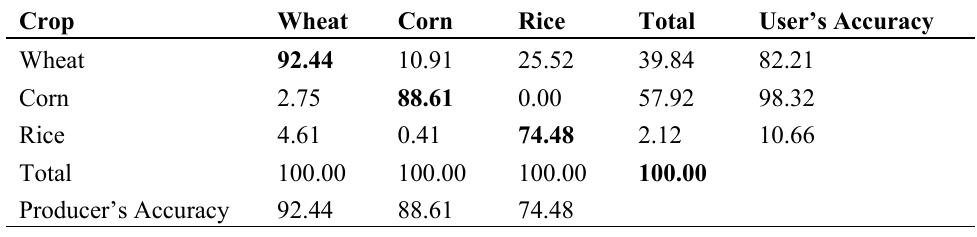
Table 7. Contingency table of 2009 LULC of agricultural land from a single Landsat scene (Path 133 Row 33).